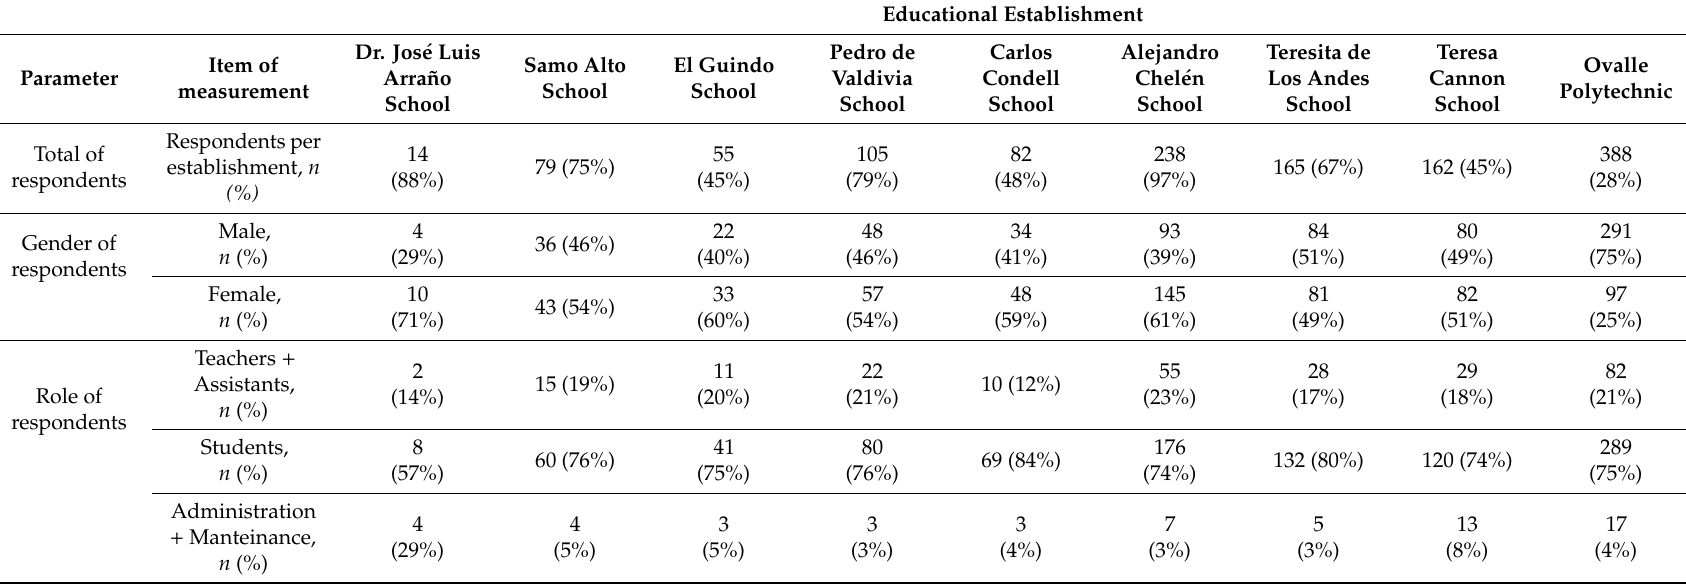
Table 1. Profile of schools